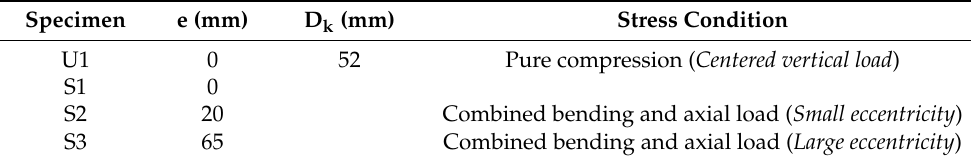
Figure 4. Loading configurations and corresponding stress states for specimens: S1, U1 ( a ); S2 ( b ); S3 ( c ) (dimensions in millimeters)—red dashed edges identify the existing column section. Table 3. Scheme of the specimens and corresponding applied loading